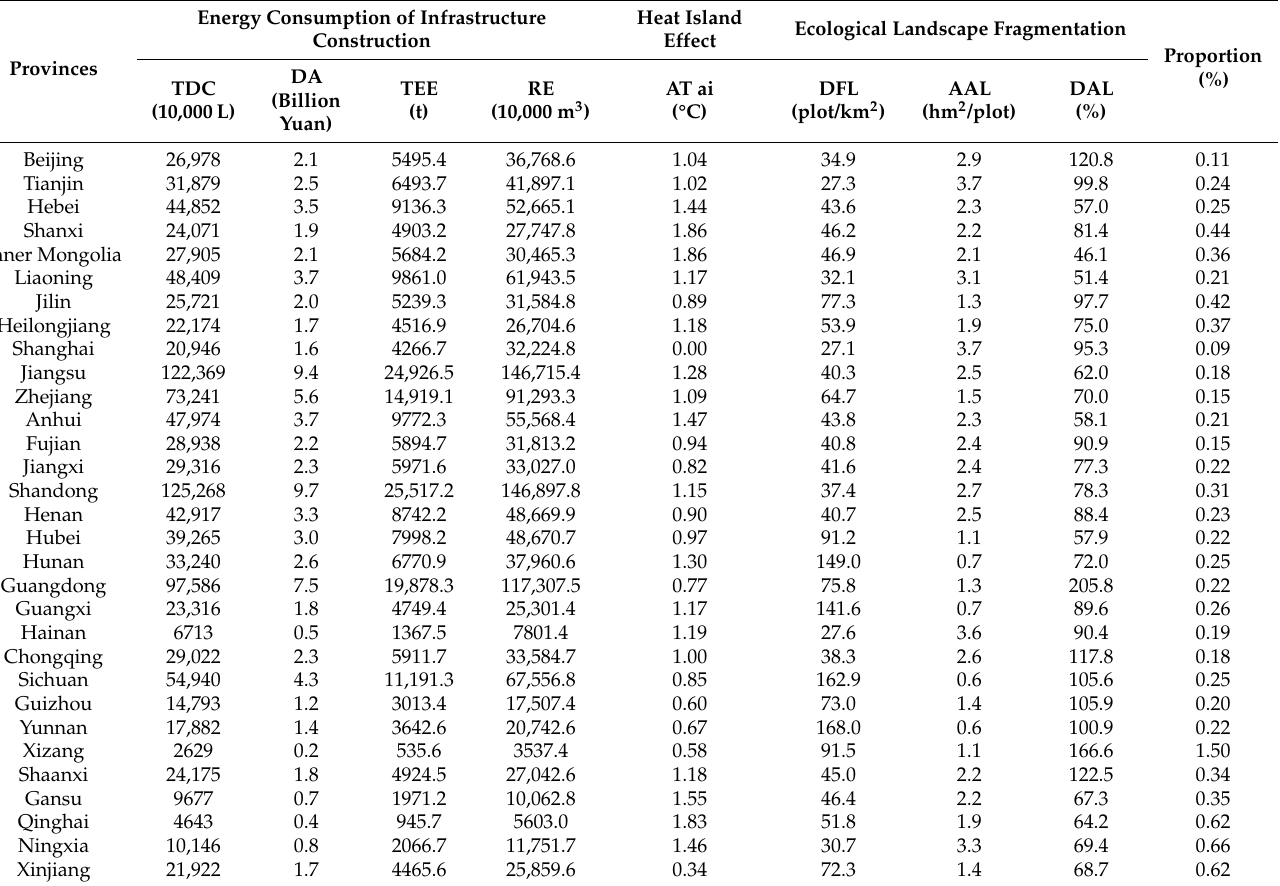
Table 2. The ecological cost in the middle stage of the land finance model and its proportion in fiscal land funds for 31 provinces in China from 2003 to